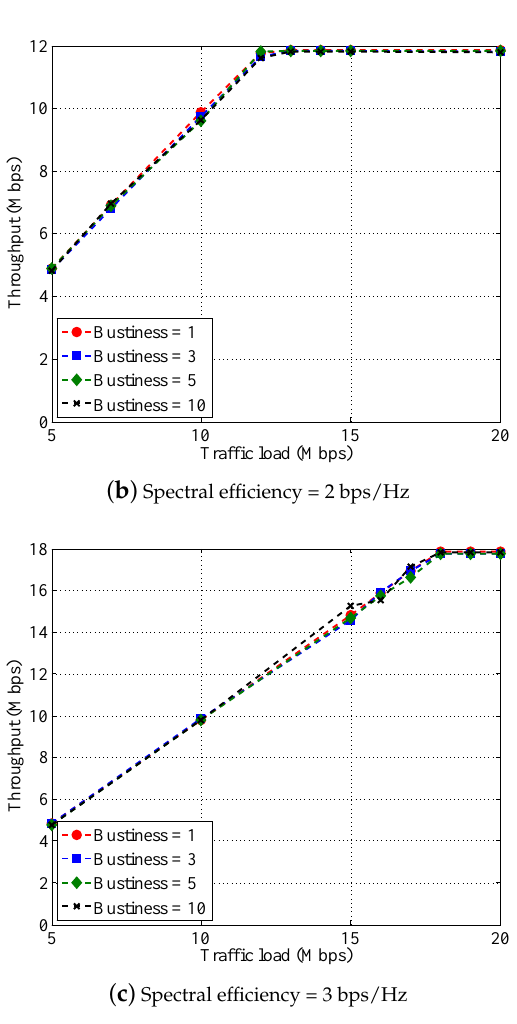
Figure 8. The network throughput at the application layer according to the traffic load (Mbps) when burstiness varies from 1–10 (RBDC).